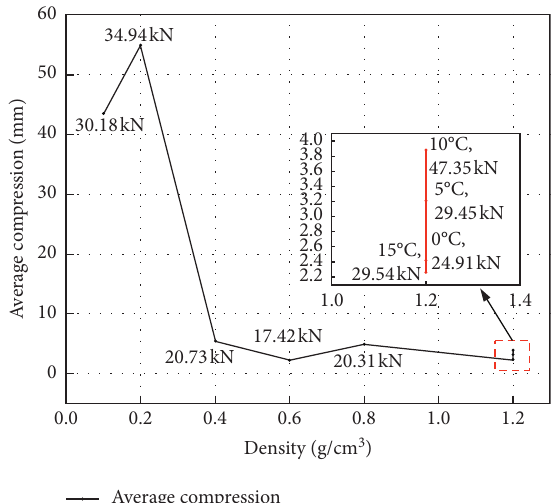
Figure 6: Relationship between density and average